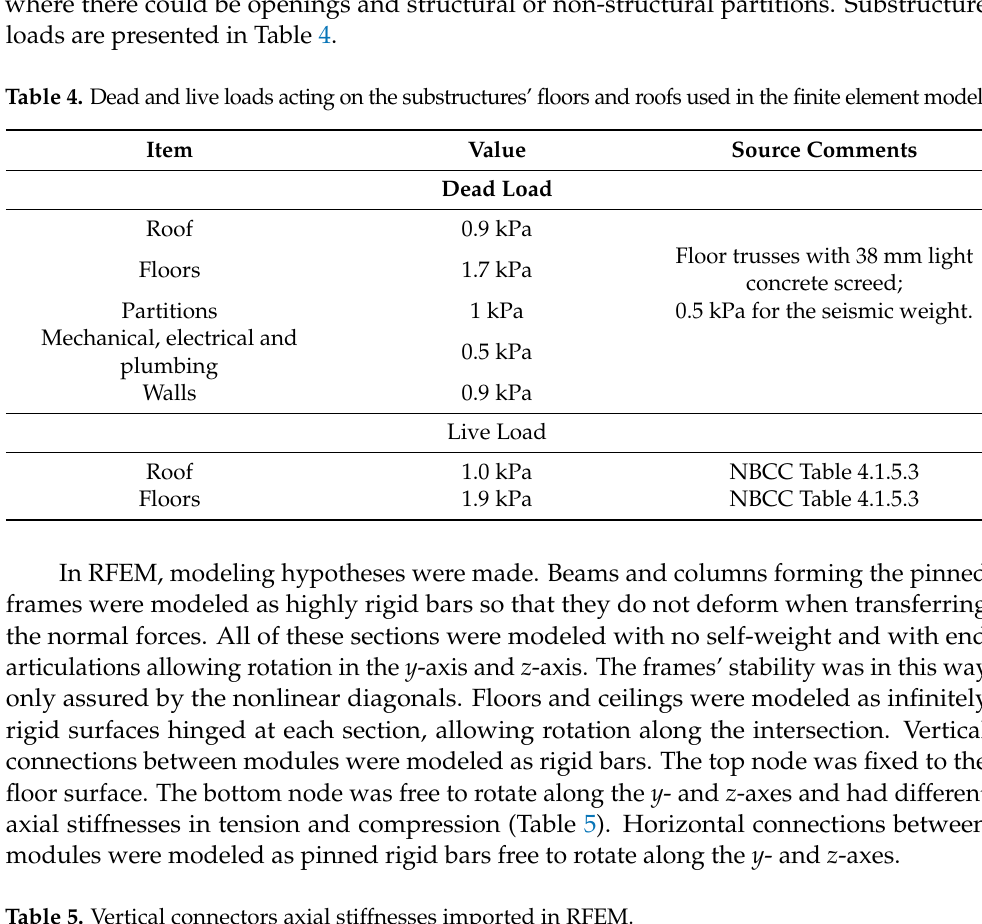
Table 5. Vertical connectors axial stiffnesses imported in